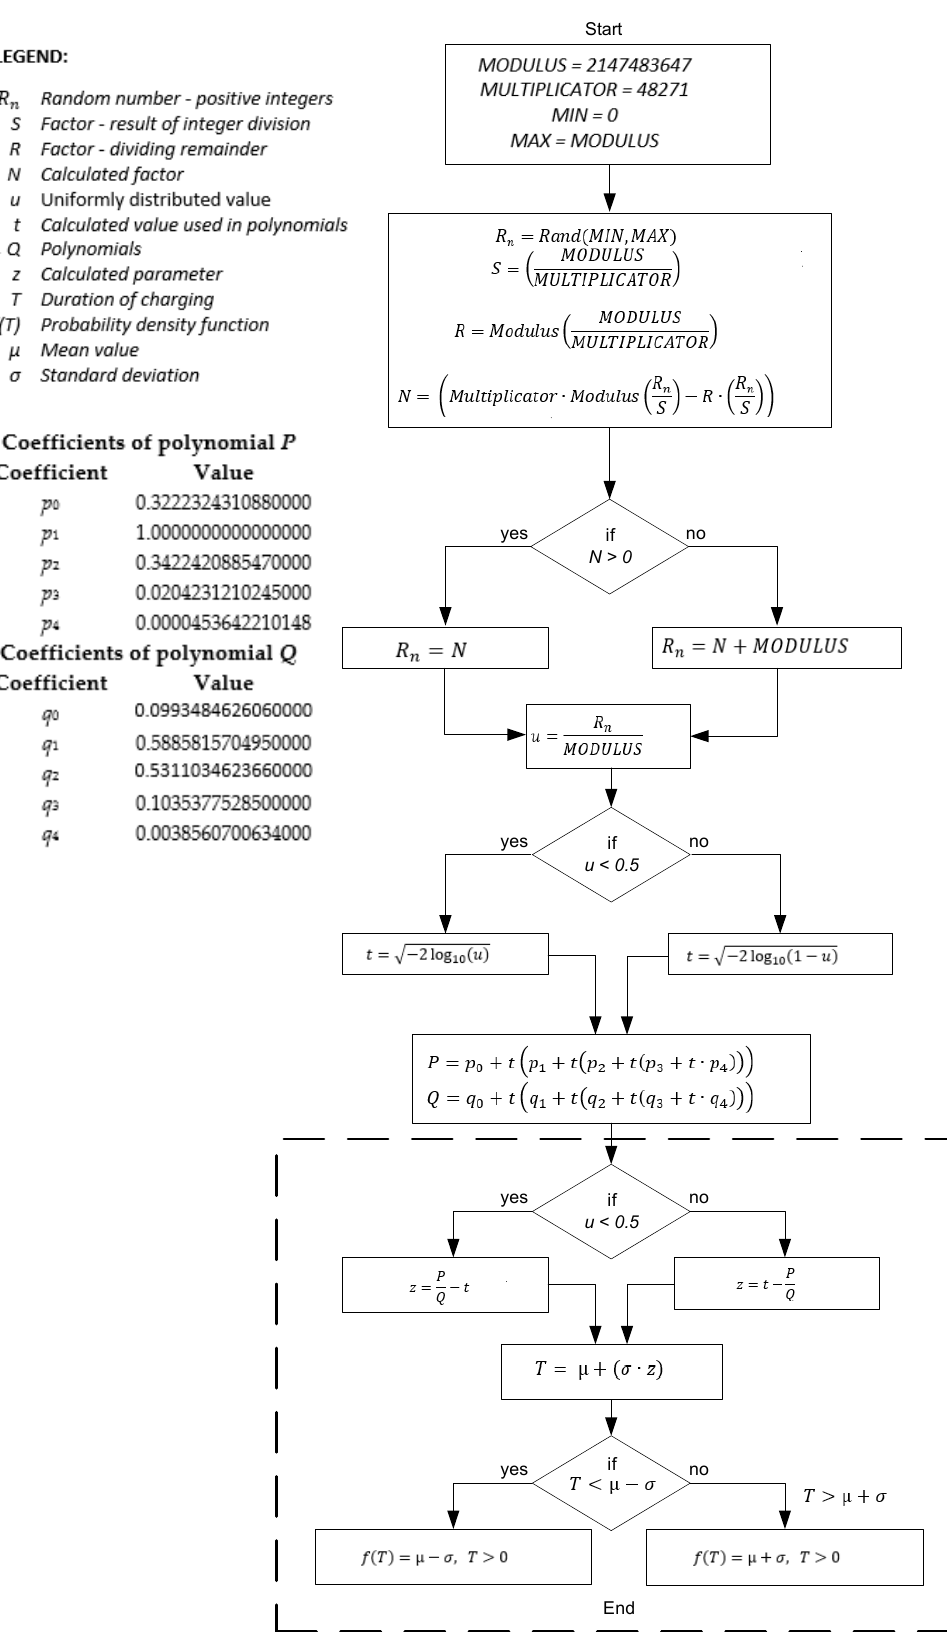
Figure 1. Modified algorithm for calculating T and f(T).